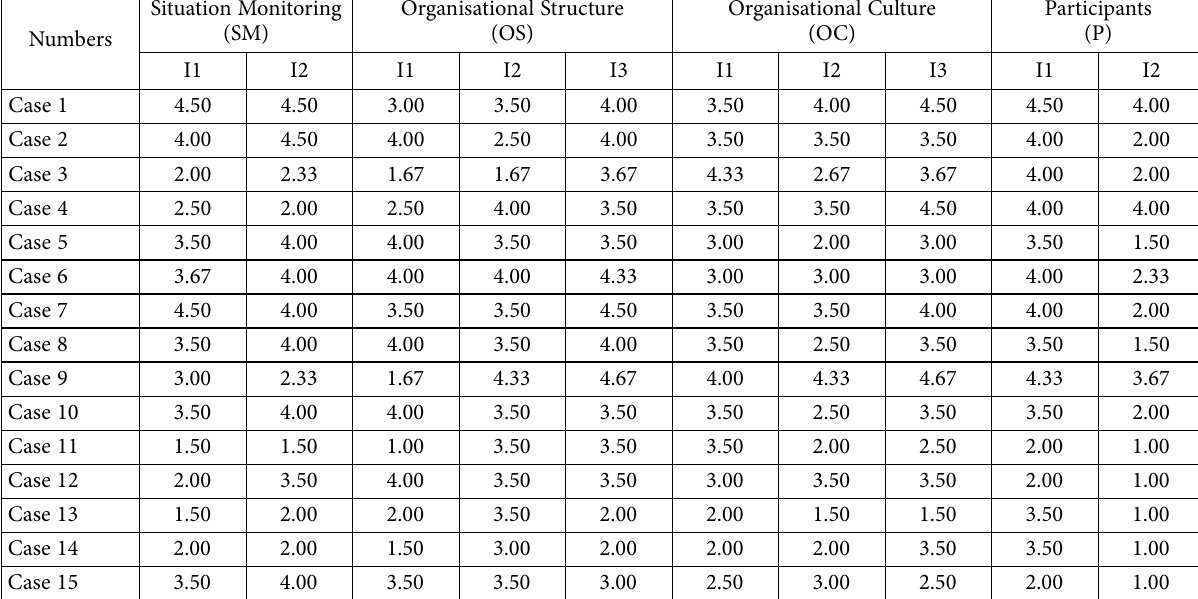
Table 3. Organisational resilience indicator results of each case